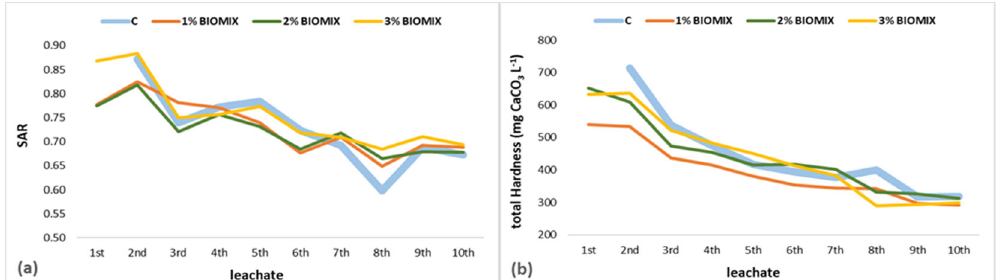
Figure 4. Changes of: ( a ) SAR values and ( b ) Total Hardness (mg CaCO 3 L − 1 ) values in the leachates of the 10 irrigation applications of the four treatments. Each value is the mean of three replicates.